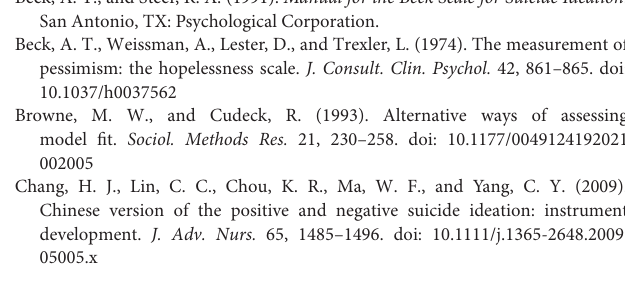
Table 3 . Based on independent samples t -tests, the psychiatric patients had lower PANSI-positive scores ( t = 6.286, df = 481, p < 0.001) and higher PANSI-negative scores ( t = 6.395, df = 481, p < 0.001) compared to medical patients. This showed that the PANSI has good criterion